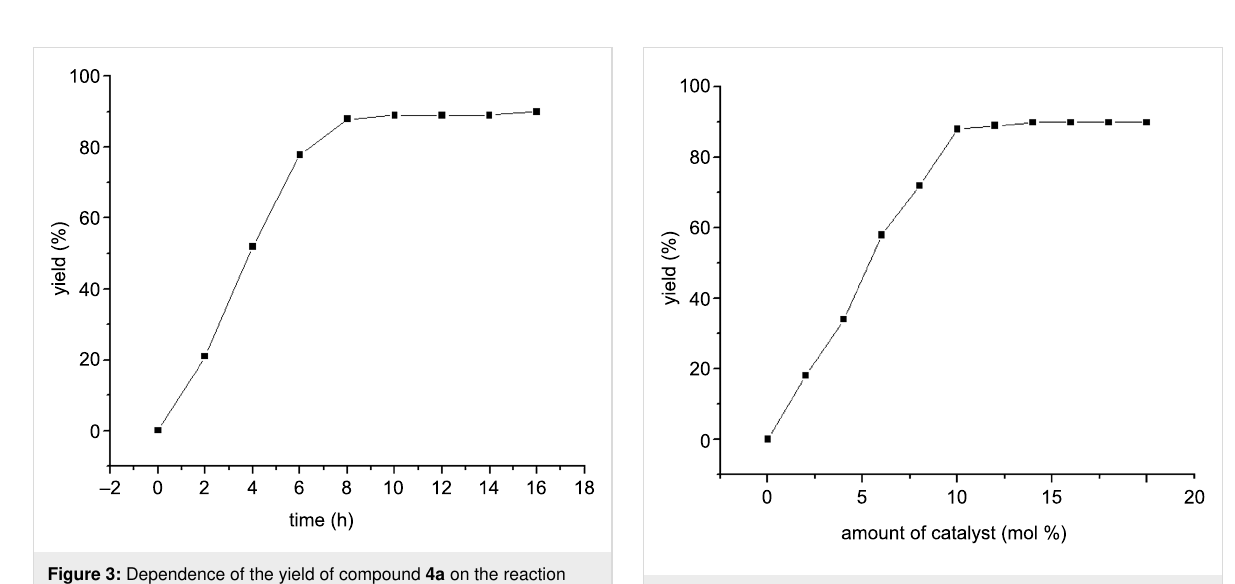
Figure 4: Yields of product 4a at different catalyst